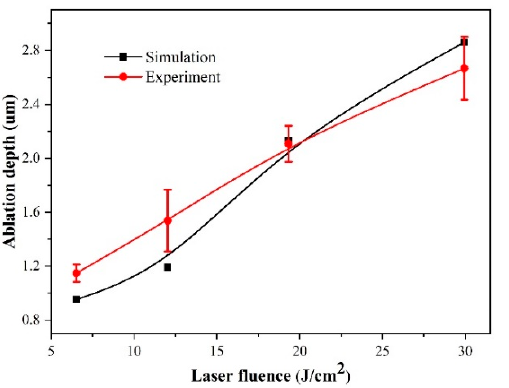
Figure 2. Comparison of ablation depth between experiment and simulation results under different